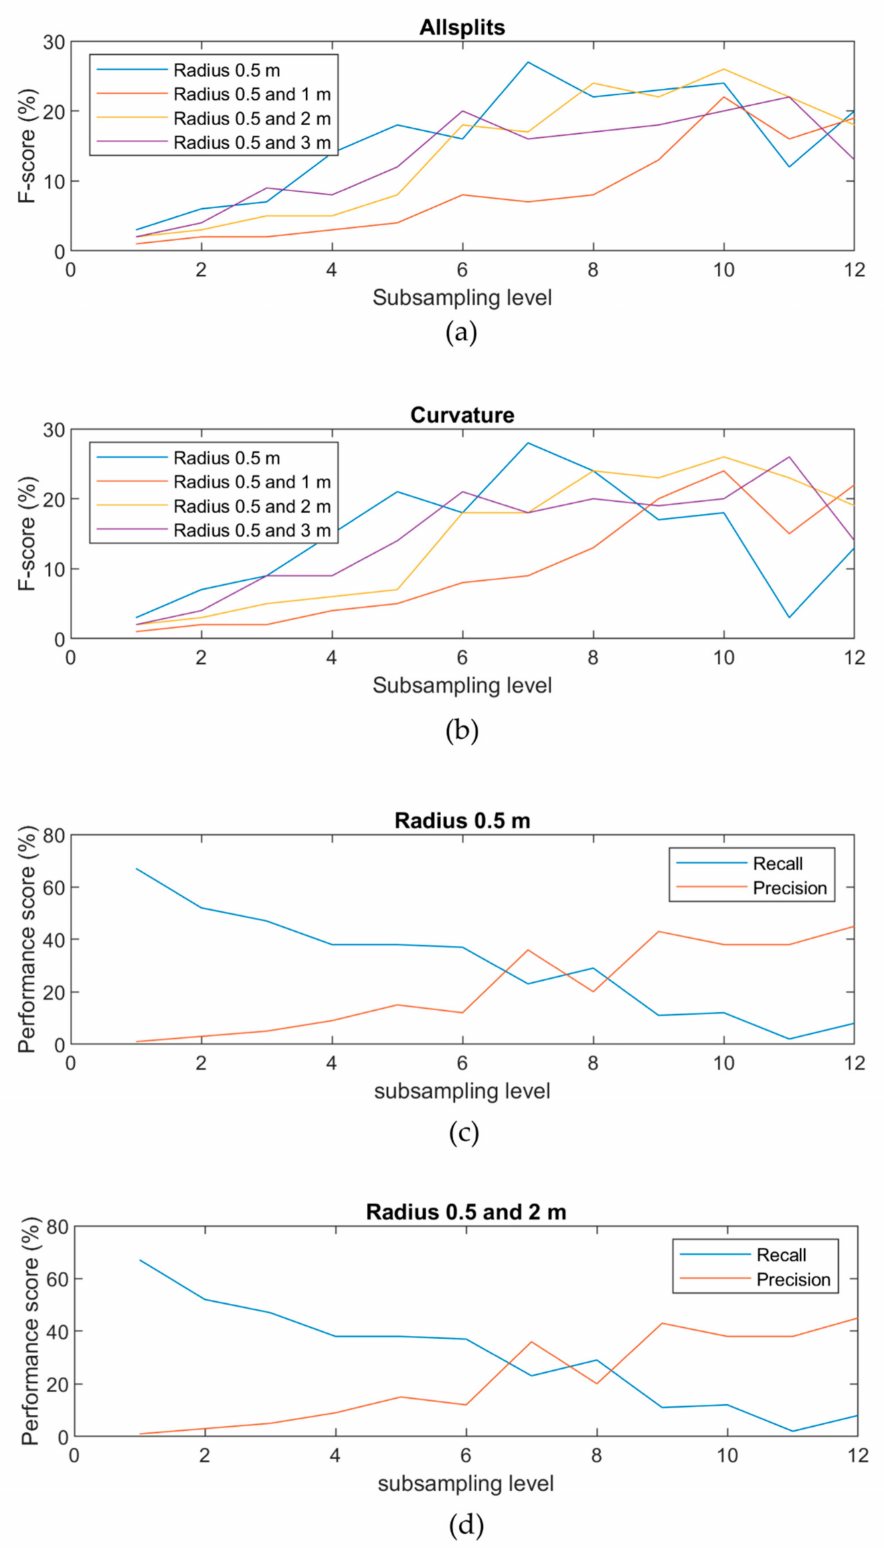
Figure 9. F-scores and performance scores. ( a ) F-score for all radii with all split predictors. ( b ) F-score for all radii with curvature split predictor. ( c ) Recall and precision for radius 0.5 m. ( d ) Recall and precision for radius 0.5 m and 2